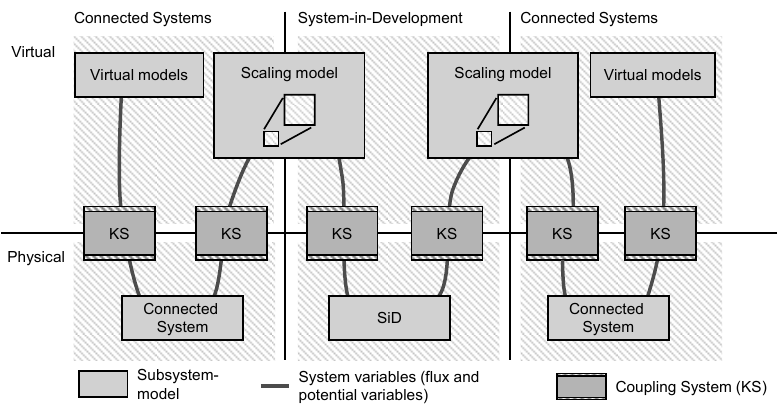
Figure 4. Example XiL architecture for scaled validation.